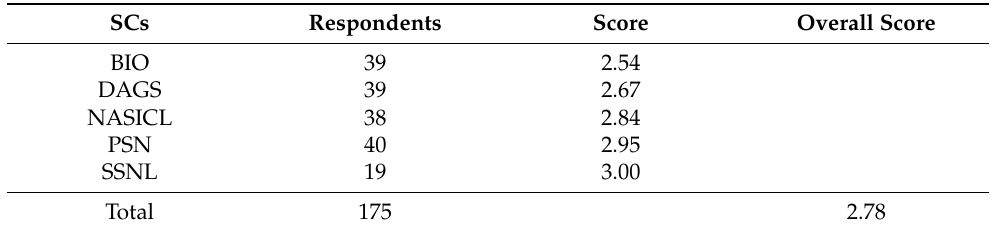
Table 3. Learning performance of